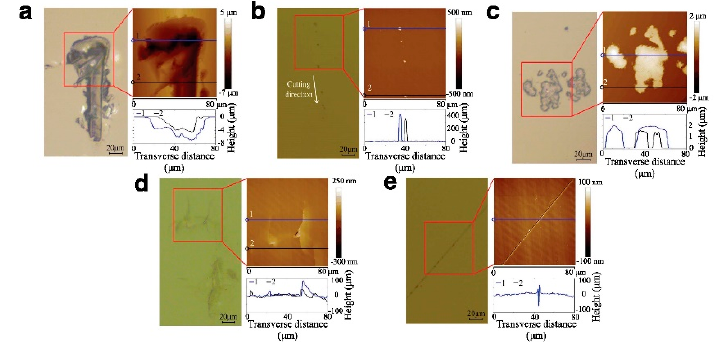
Figure 10. Optical microscopy images of the five kinds of KDP surface defects. ( a ) Fracture pits; ( b ) Convex scratches; ( c ) Surface protuberances; ( d ) Cracks; and ( e ) Plastic scratches [20].